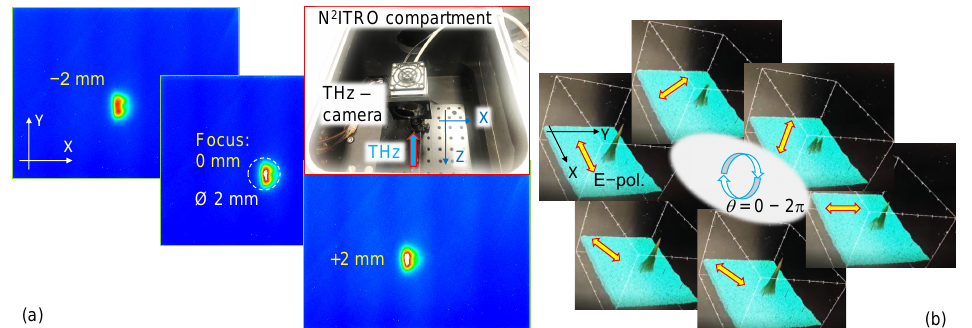
Figure A3. Polarisation contents over the focal beam has non-uniform structure. ( a ) Near-focus (at − 2 mm and +2 mm) images of the THz beam (AuSy) taken with Microxcam-384i camera (inset). ( b ) Snapshots from 3D rendering video of intensity distributions with a polariser rotating before the focus (old 1st mirror).